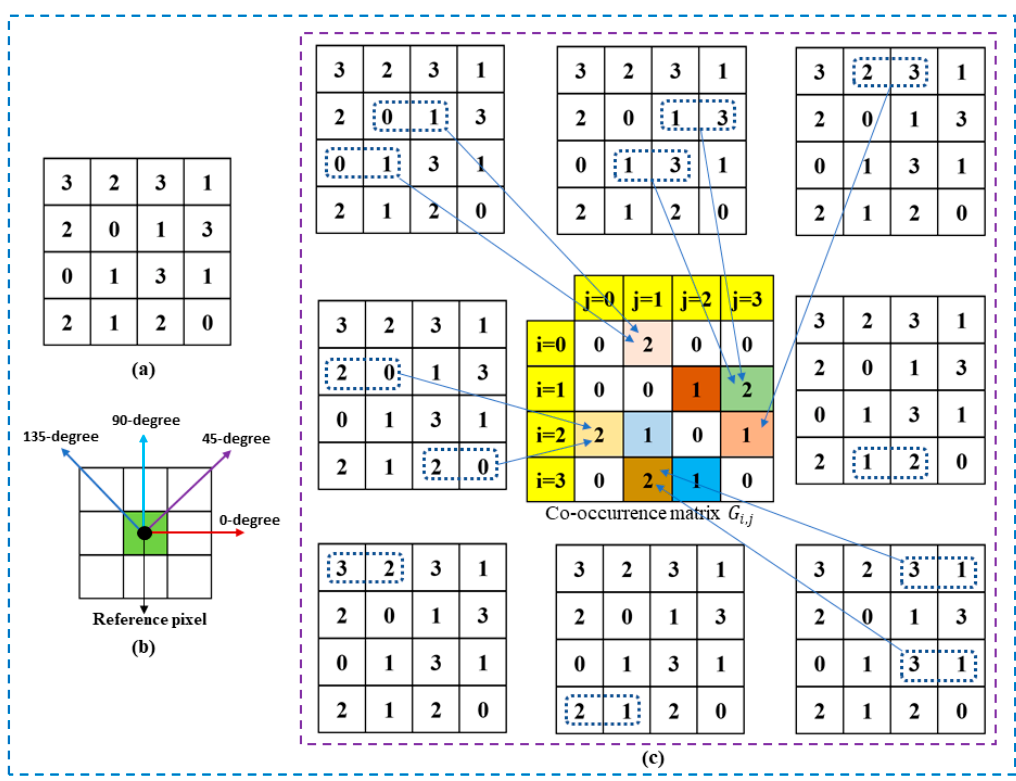
Figure 5. Computation of GLCM from an image patch: ( a ) The input image patch; ( b ) A reference pixel in the given image and the preferred orientations of GLCM; ( c ) Computation of the co-occurrence matrix. Note: Different colors are used in the above diagram to indicate specific pixel pair combinations.